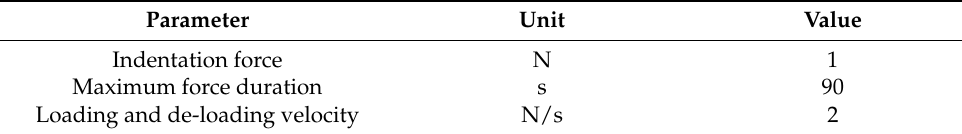
Table A4. Process parameters for measuring micro-mechanical